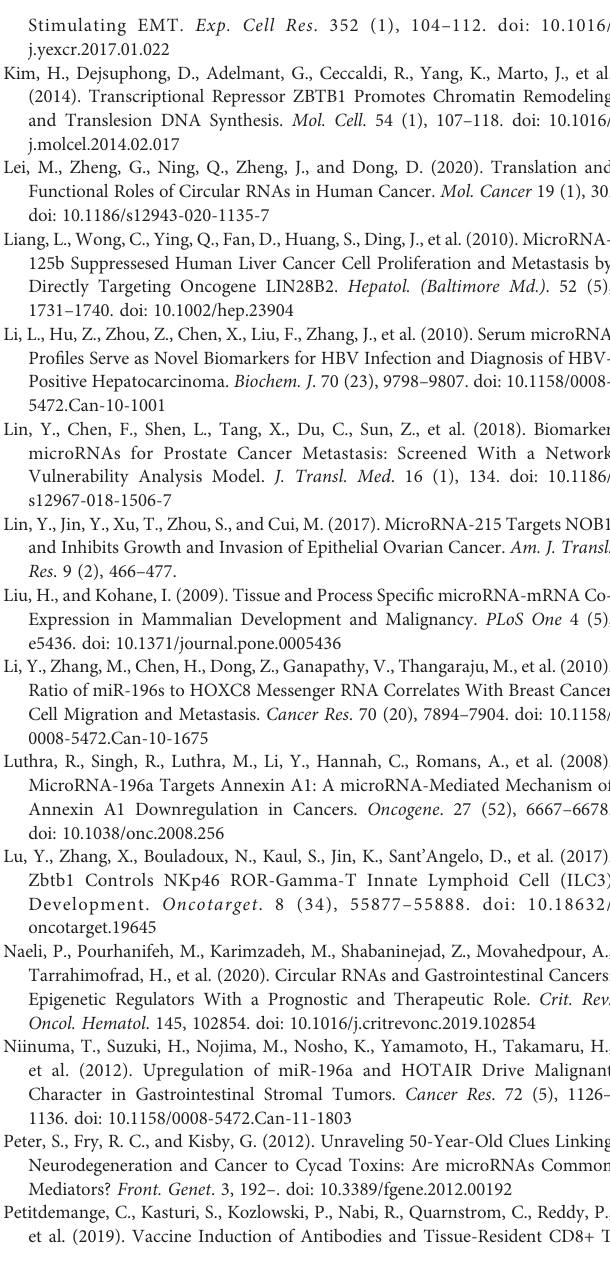
Supplementary Table 5 | CircRNA list commented to (1) circRNA_ID: circRNA number (2) strand: plus or minus chain (3) annotated_circRNA_site: known circRNA location information (4) annotated_circRNA_ID: known circRNA ID. Supplementary Table 6 | Statistical tables of circRNA quantity between different expression levels. Supplementary Table 7 | (1) Id: circRNAID;(2) baseMean:fragmentsisnormalized, andtheaveragevalueunderthetwoconditions;(3)log2FoldChange:takeslog(4)lfcSE: Supplementary Table 8 | (1) Pathway of microRNA target genes: pathway of microRNA target gene ID; (2) Pathway: pathway name; (3) DEGs with pathway